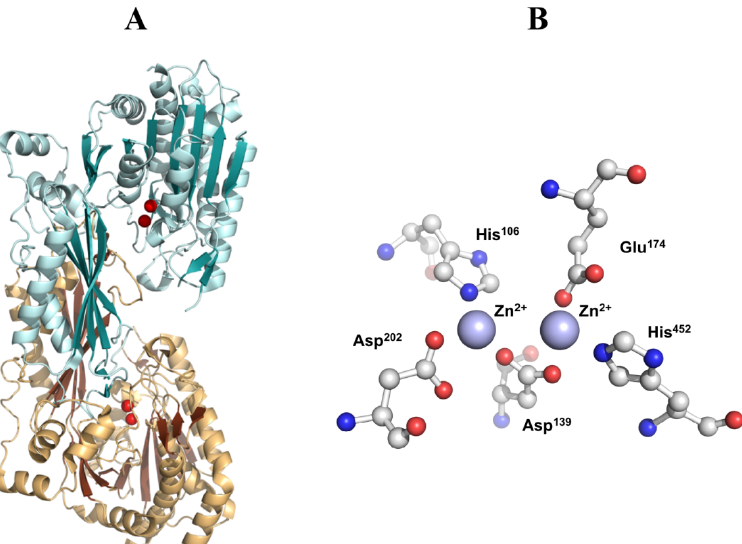
Figure 8. ( A ) Ribbon diagrams of dimer form of human CN1, in which the two catalytic zinc ions of the active center are represented as red spheres. ( B ) Active site of human CN1. The zinc(II) ions of the di-nuclear complex species are represented as violet spheres.